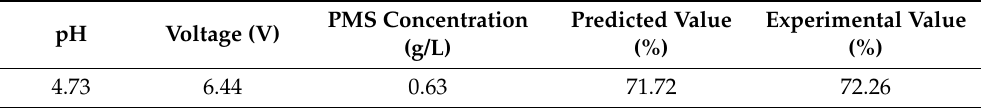
Table 1. The predicted and experimental values under optimized process